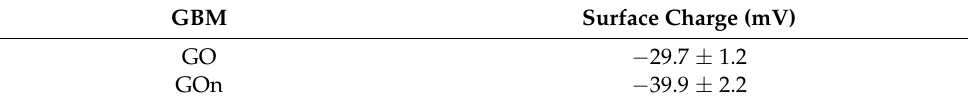
Table 1. Zeta potential measurements of GO and GOn aqueous dispersions.